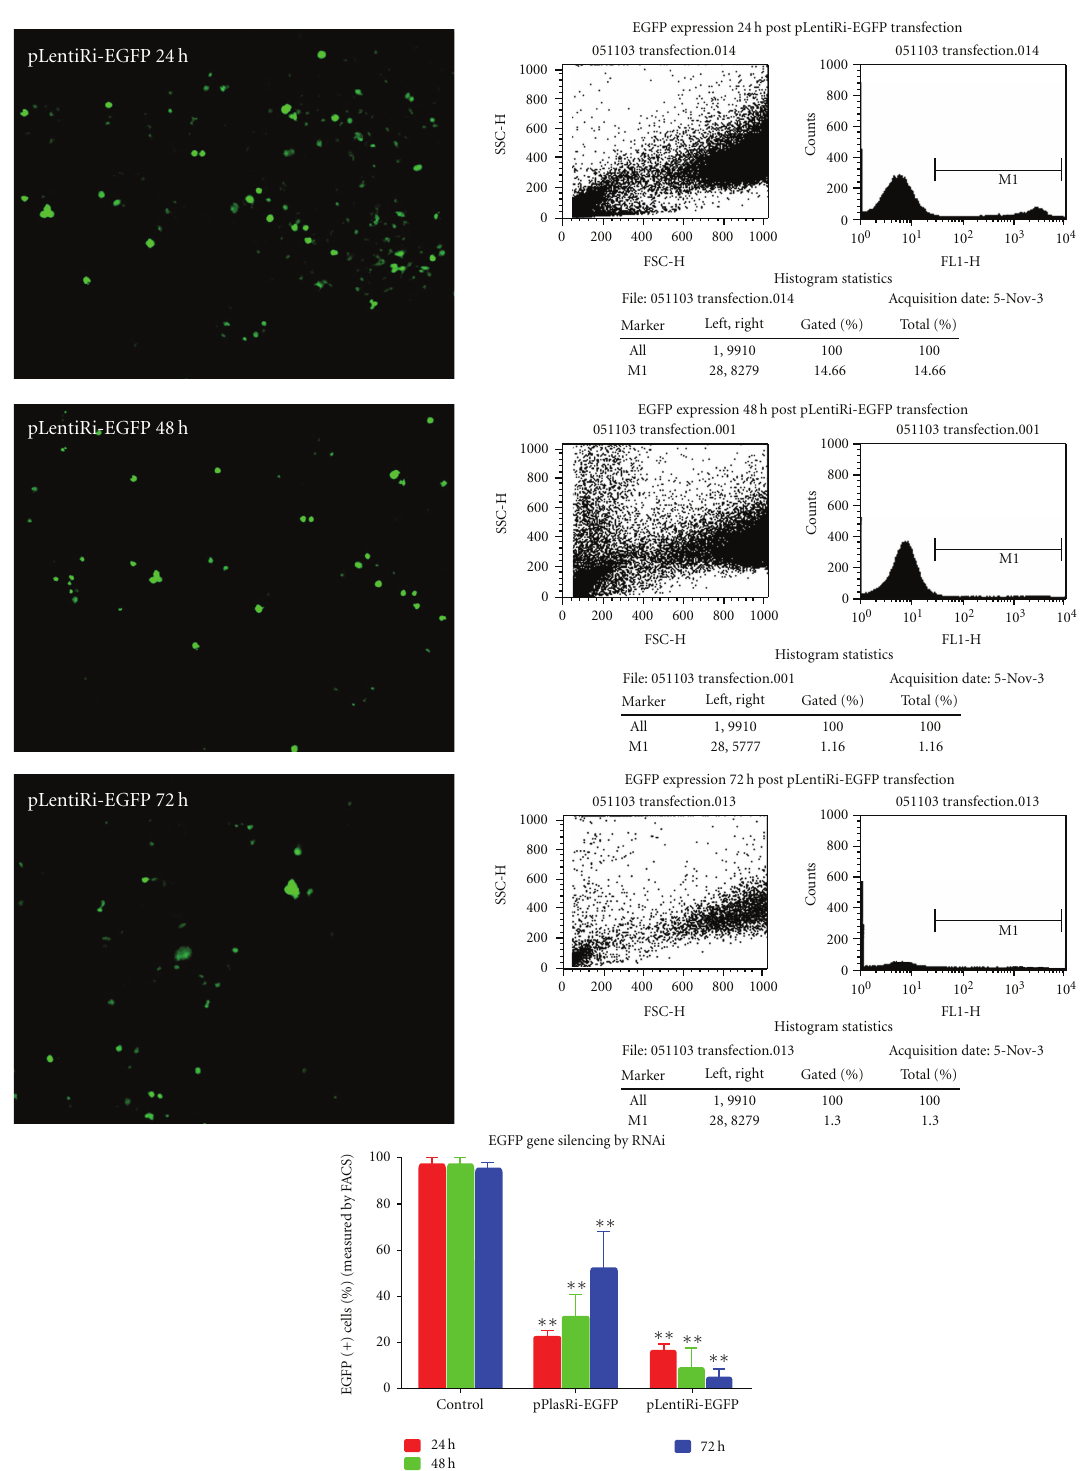
Figure 1: Gene silencing of EGFP by transfection of lentiviral and non-lentiviral expression constructs in vitro. RNAi EGFP gene silencing was tested at 24, 48, and 72 hrs in EGFP stably expressing S7 cells post transfection of an EGFP-RNAi expression construct (pPlasRi-EGFP) and a lentiviral RNAi construct (pLentiRi-EGFP). Fluorescence microscope images of cultured cells are demonstrated as well as the FACS analysis. The percent of EGFP positive (+) cells (mean ± SEM) was assessed using FACS results, and these are shown graphically. There was a significant decrease of EGFP 24 hrs after both transfections compared to controls ( ∗∗ P < . 01 in comparison with controls). The pPlasRi-EGFP plasmid showed a transient silencing e ff ect in comparison with a persistent inhibition by the pLentiRi-EGFP, which produced a continuing inhibition of EGFP (+) cells at 48 and 72 hrs. Gene silencing of EGFP by the pLentiRi-EGFP plasmid remained at 95.91% at